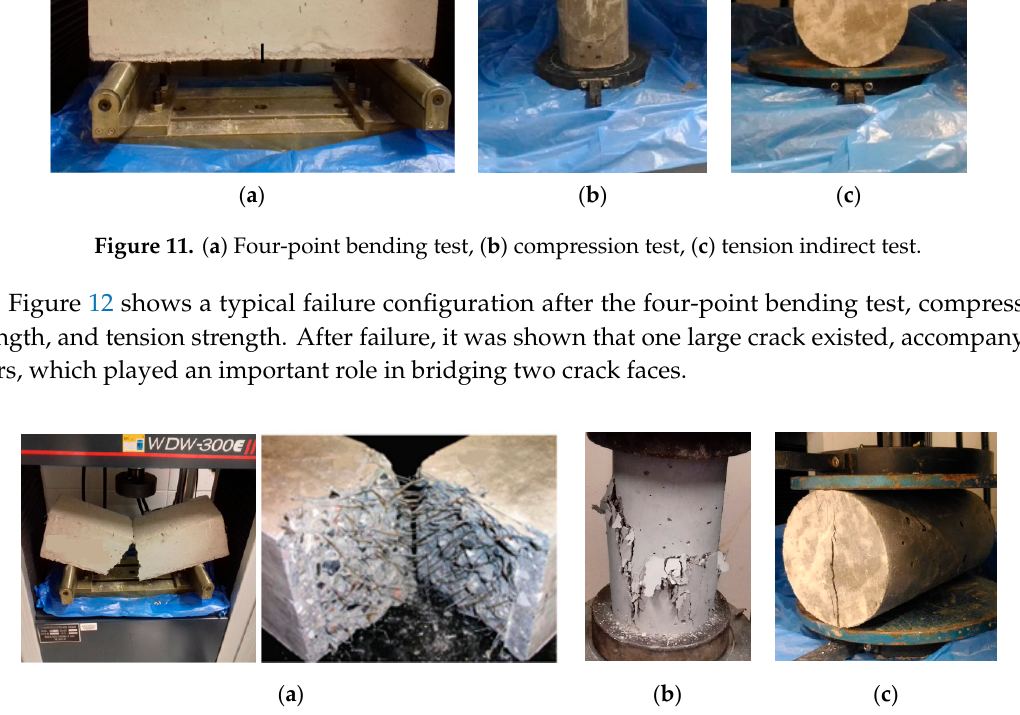
Figure 12. Result of experimental tests. ( a ) Four-point bending beam test, ( b ) compression test, ( c ) tensile indirect test.